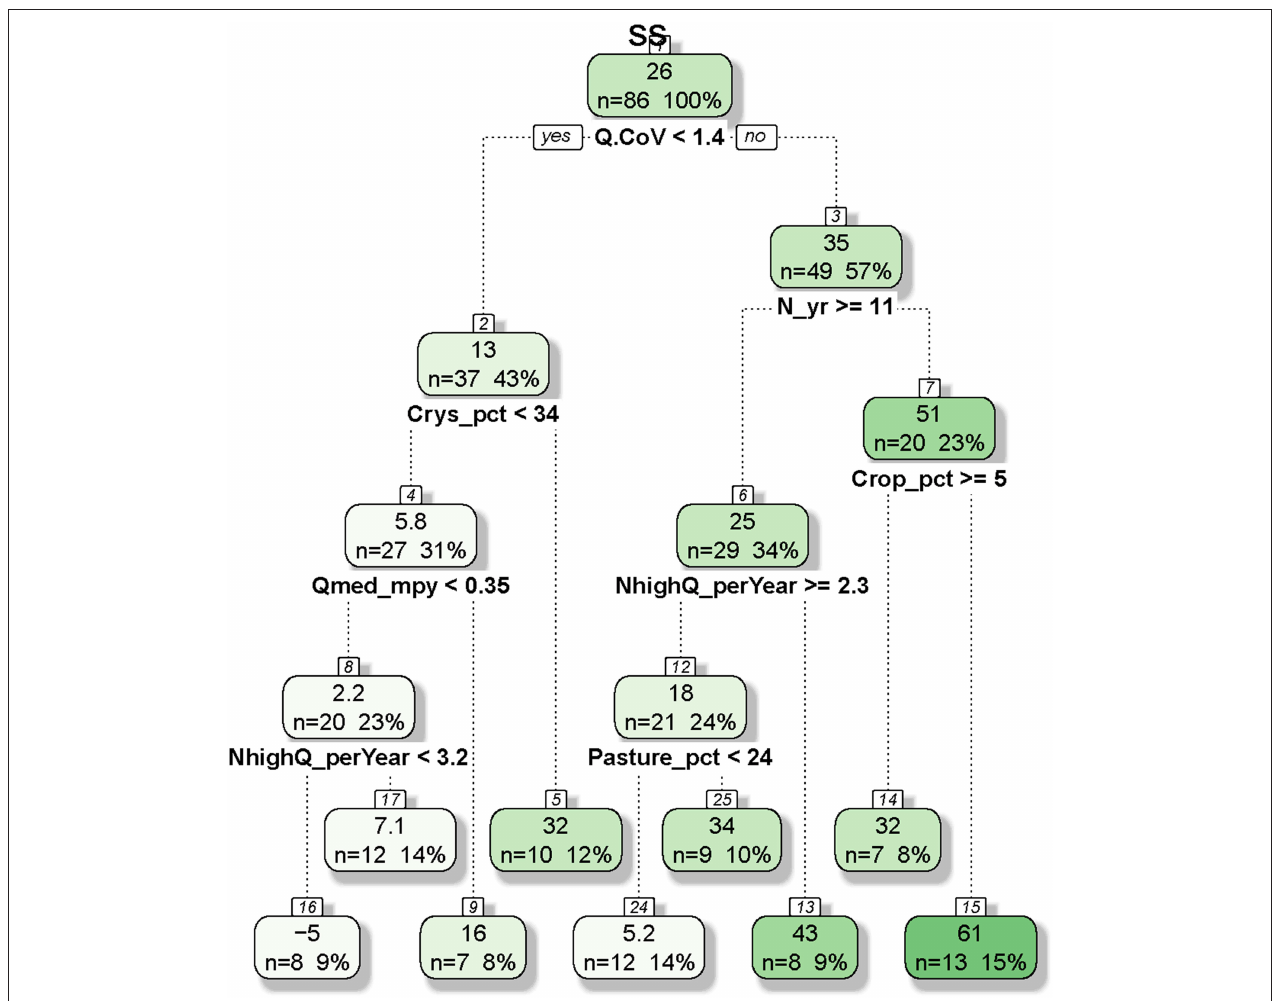
FIGURE 7 | Regression and classification tree developed for constituent flux bias for suspended sediment (SS). In each node, the top number represents the average bias (percent) of cases and the bottom numbers represent the number of cases and the percentage of cases (in bracket). Of the 90 cases for SS, four were excluded due to missing values in land use and/or geology